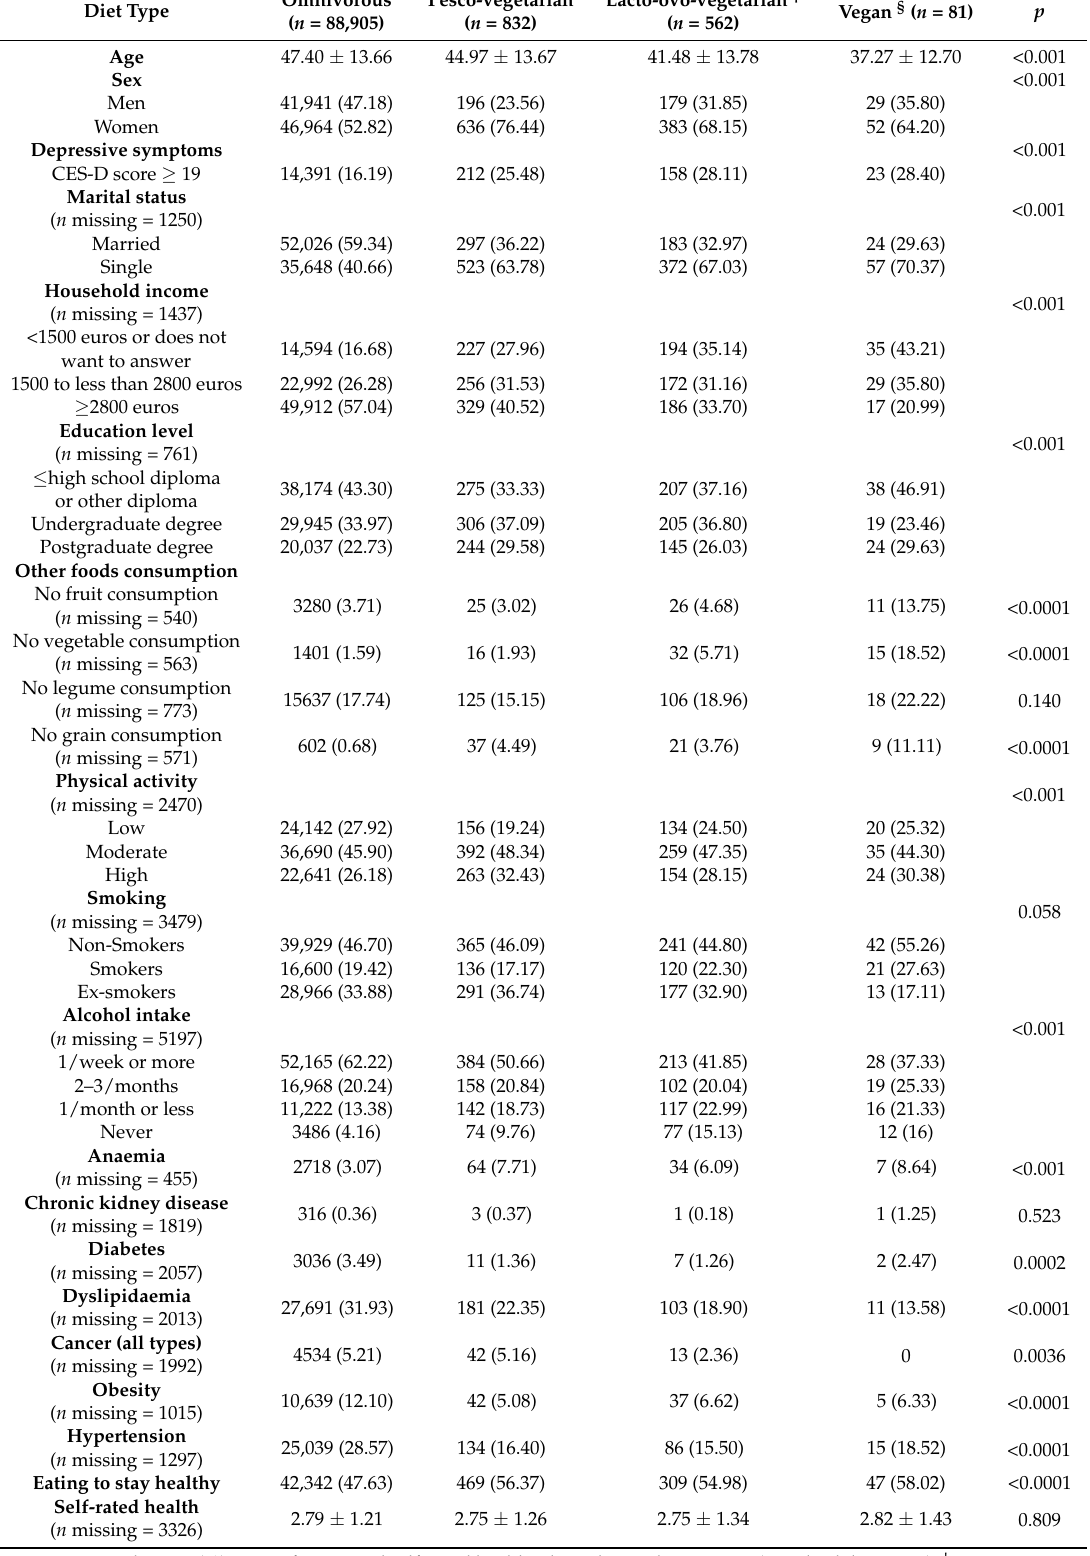
Table 1. Participant’s characteristics by diet